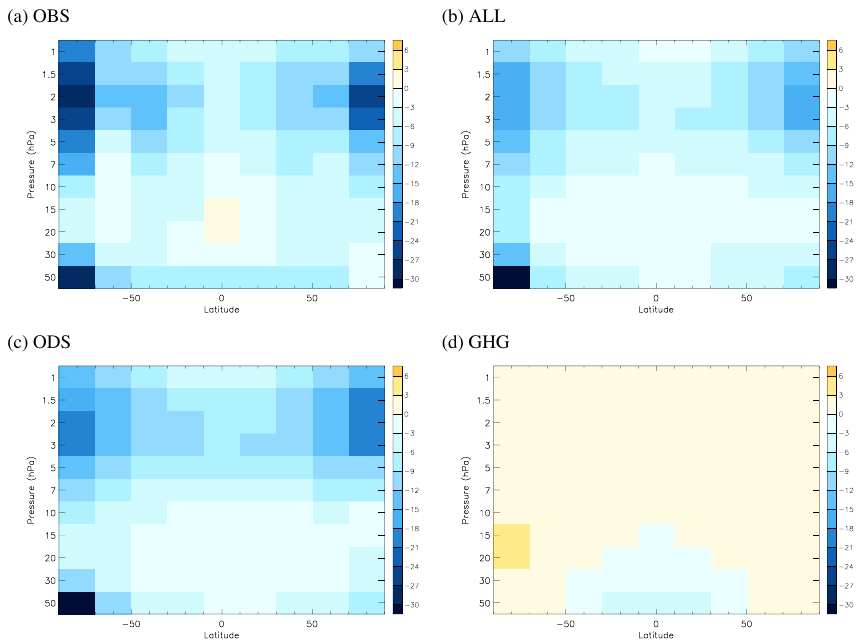
Fig. 4. Zonal mean linear least-squares trends in ozone (change over the period 1979–2005 expressed as a percentage of the observed 1979– 2005 climatology) in SAGE-corrected SBUV observations (McLinden et al., 2009) (a) , and simulated in response to combined anthropogenic and natural forcings (b) , ODS changes (c) , and GHG changes (d)